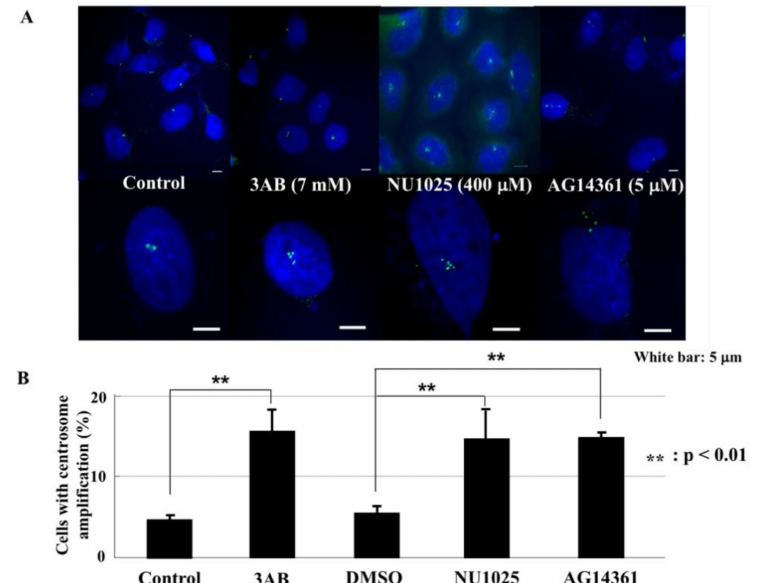
Figure 1. PARP inhibitors induced centrosome amplification in CHO-K1 cells. ( A ) CHO-K1 cells were cultured for 72 h with PARP inhibitors and stained with anti- γ -tubulin antibody. ( B ) Cells with centrosome amplification by PARP inhibitors were summarized. Significance was assessed against the control. ** p < 0.01. PARP inhibitor 3AB was dissolved directly in the culture medium, and NU1025 and AG14361 were first dissolved in DMSO and diluted by the culture medium to the designated concentration. The final concentration of DMSO was 0.01%, which was not